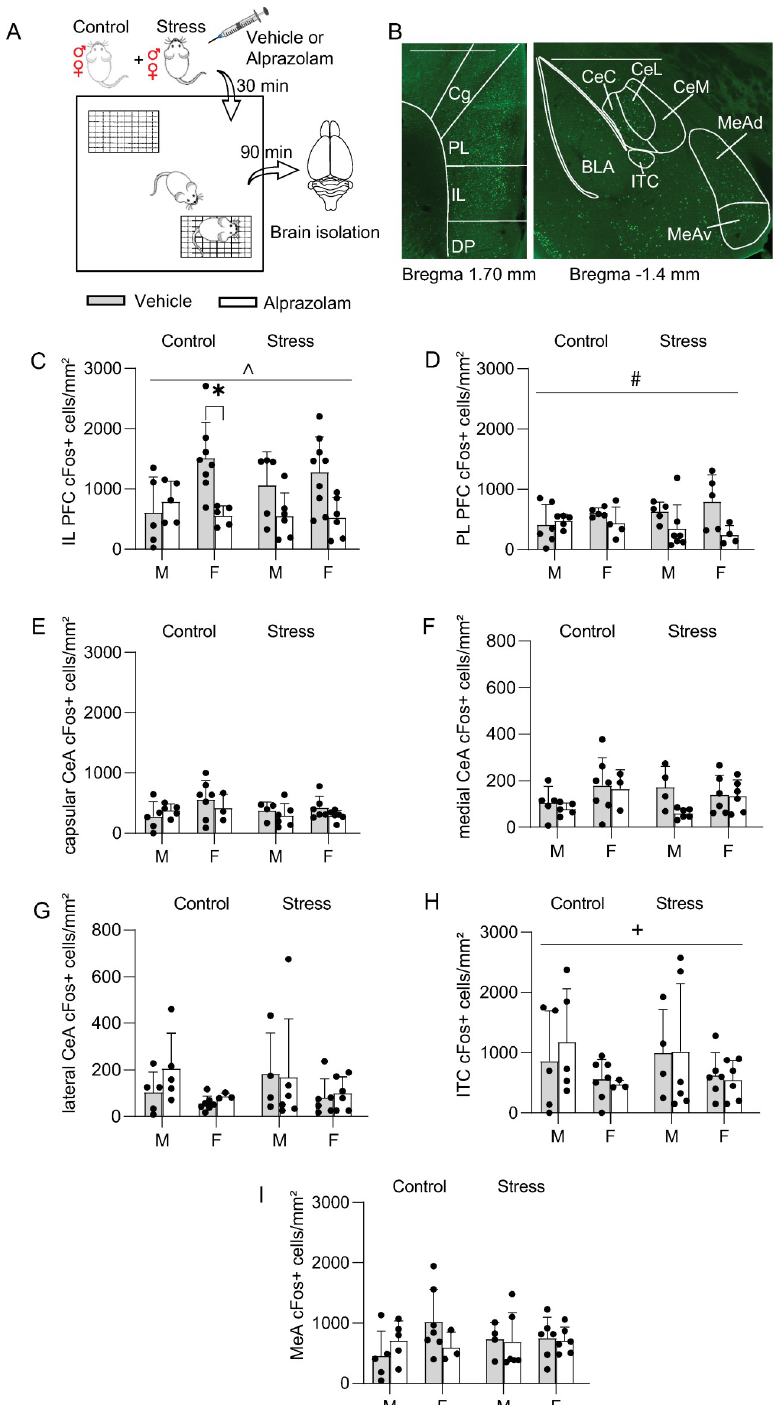
Fig 2. cFos expression patterns following social approach. A. Schematic of the experiment. B. Representative images of cFos staining results in mPFC ( left ) and amygdala ( right ). CeC = capsular CeA, CeL = lateral CeA, CeM = medial CeA, IL = infralimbic mPFC, ITC = ventromedial intercalated nucleus of amygdala, MeAd = dorsal MeA, MeAv = ventral MeA, PL = prelimbic mPFC. Scale: 1000 μ m. C-I. Average number of cFos+ cells / mouse. C. Alprazolam reduced cFos expression in the IL in control females. D . Alprazolam lowered cFos+ cells in the PL. E-G. cFos expression in the capsular, medial, or lateral CeA was not significantly affected by stress, sex, or drug. H. cFos expression in the ventromedial ITCs were greater in males. I. cFos expression in the MeA was unaffected by stress, sex,